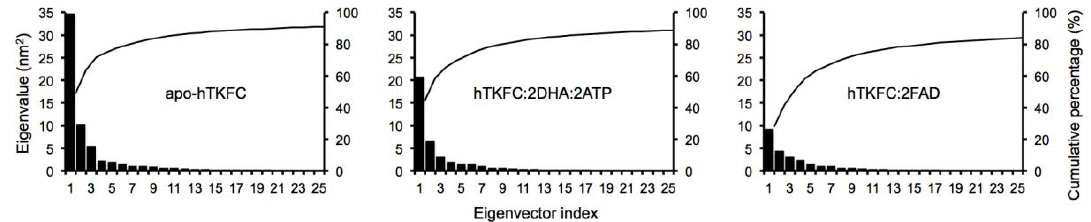
Figure 8. Essential dynamics of hTKFC and its complexes with kinase or cyclase substrates. The first 25 eigenvectors or principal components are shown in decreasing order of eigenvalue. The bars represent the eigenvalues. The lines represent the cumulative percentages of eigenvalues.